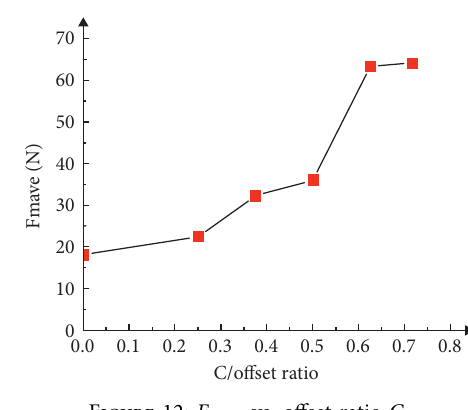
Figure 12: F mave vs. offset ratio C .